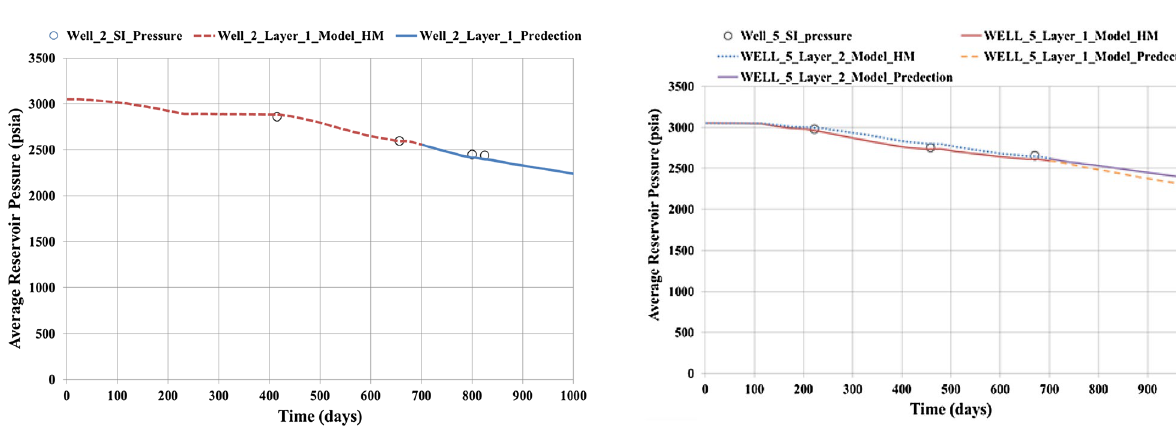
Fig. 12 Well 4 pressure history match and prediction (case 1)